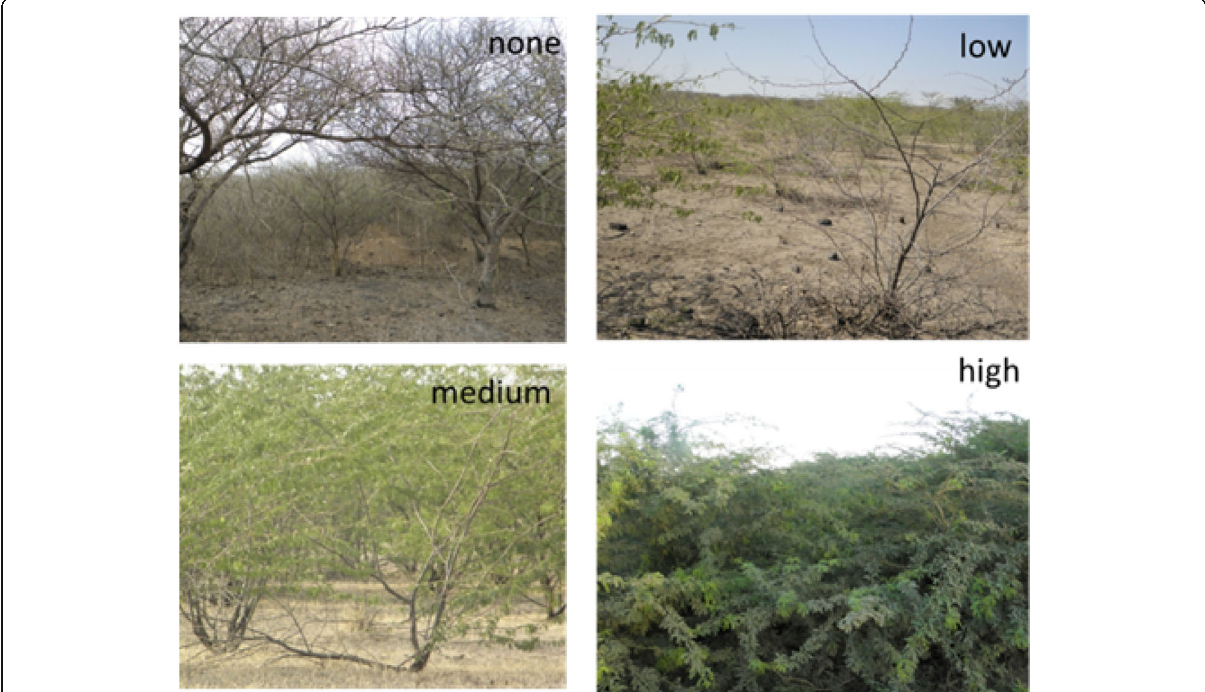
Fig. 2 The different invasion categories of P. juliflora in the two study sites. No P. juliflora individuals ( “ none ” ; P. juliflora cover ≤ 3%), low cover ( “ low ” ; P. juliflora cover 3 – 40%), intermediate cover ( “ med ” ; P. juliflora cover 40 – 60%), and high cover ( “ high ” ; P. juliflora cover >